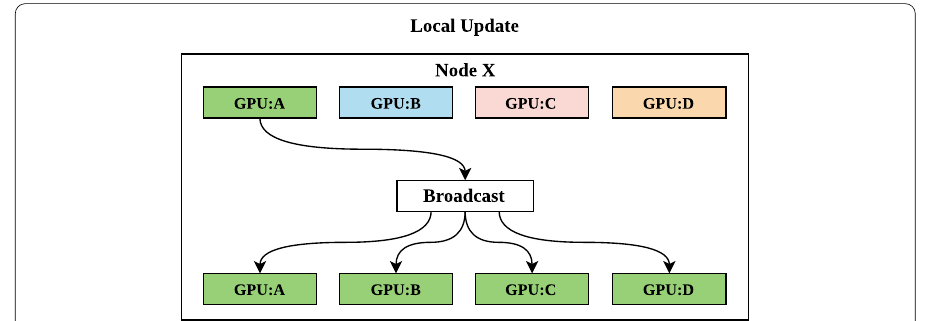
Fig. 4 Local Update (Broadcast) Schematic of the local update step to be performed after the global synchronization step shown in Fig. 3. The group member responsible for the global communication, in this case GPU:A, sends its network parameters to all other node-local GPUs, which replace the old parameters on those